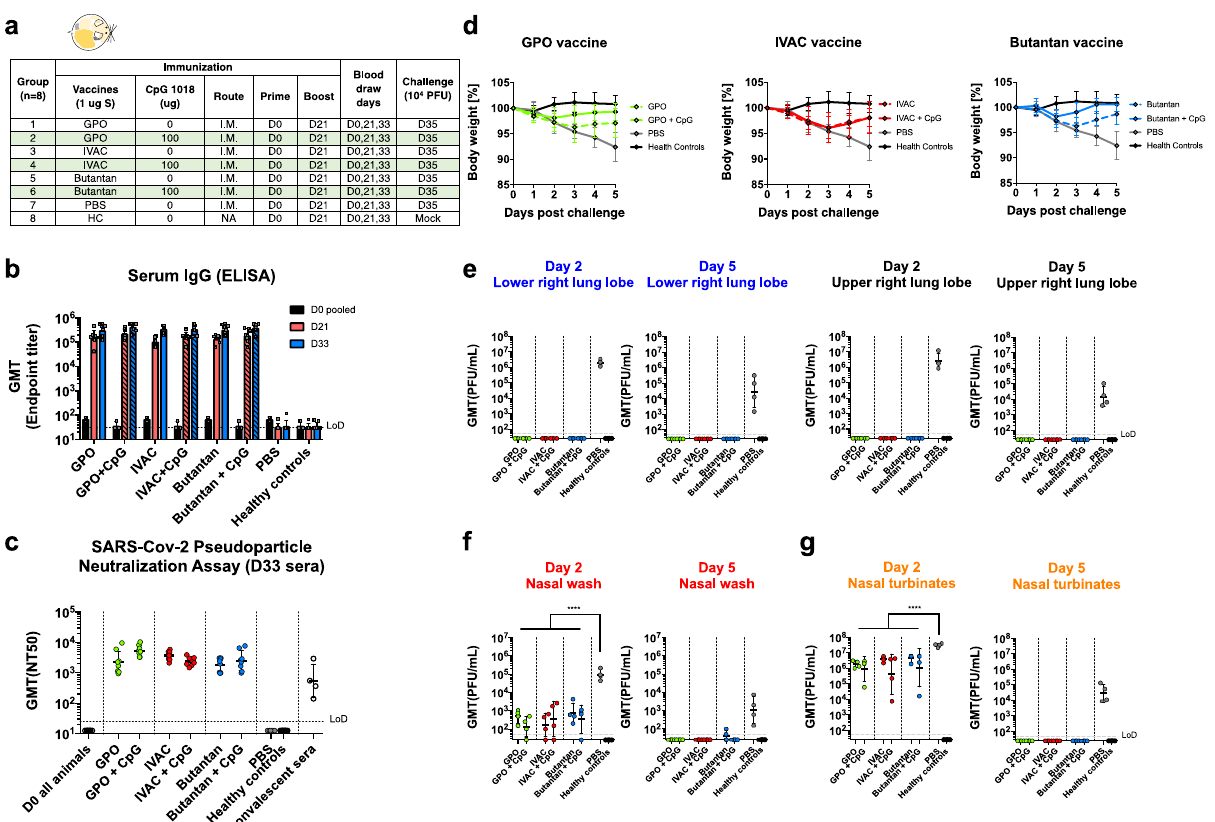
Fig. 4 GMP lots of inactivated NDV-HXP-S produced by in fl uenza virus vaccine manufacturers induce a protective antibody response in hamsters. a Design of the study. Nine-to-eleven-week-old female Golden Syrian hamsters were used. Groups 1 – 6 ( n = 8) were vaccinated with 1 µ g of spike antigen of inactivated NDV-HXP-S from GPO, IVAC, and Butantan in the absence or presence of CpG 1018. Group 7 ( n = 8) was vaccinated with PBS as the negative control. Group 8 ( n = 8) was not vaccinated (HC, healthy controls). The vaccine was administered via the intramuscular (I.M.) route at D0 and D21. Blood was collected at D0, D21, and D33. Groups 1 – 7 were challenged with 10 4 PFU of the USA-WA1/2020 strain at D35. Group 8 was mock-challenged with PBS. b Spike-speci fi c serum IgG. Antibodies in pre-vaccination (D0, black), post-prime (D21, red), and post-boost (D33, blue) sera were measured by ELISAs (solid bars: unadjuvanted; pattern bars: adjuvanted). GMT endpoint titers were graphed. The error bars represent geometric SD. c Neutralizing activity of serum antibodies. A pseudo-particle neutralization assay was performed by Nexelis to measure neutralization titers of post-boost sera (D33). Human convalescent sera were included in the same assay as the controls (LoD = 1:25; An ID 50 = 1:12.5 was assigned to negative samples). d Body weight changes of hamsters. Body weights were monitored for 5 days after the challenge. The error bars represent geometric SD. e Viral load in the lungs. The lower right and upper right Lung lobes of a subset of animals ( n = 4) from each group were collected at day 2 and day 5 post challenge. Each lung lobe was homogenized in 1 mL PBS. f Viral load in nasal washes and g nasal turbinates. On day 2 and day 5 post challenge, nasal washes were collected in 0.4 mL of PBS. Nasal turbinates were homogenized in 0.5 mL PBS. Viral titers were measured by plaque assay on Vero E6 cells and plotted as GMT of PFU/mL (LoD = 50 PFU/mL; a titer of 25 PFU/mL was assigned to negative samples). The error bars represent geometric SD. Statistical difference was analyzed by ordinary one-way ANOVA corrected for Dunnett ’ s multiple comparisons test (**** p < 0.0001). c – g Green: GPO; red: IVAC; blue: Butantan; gray: PBS: black: healthy